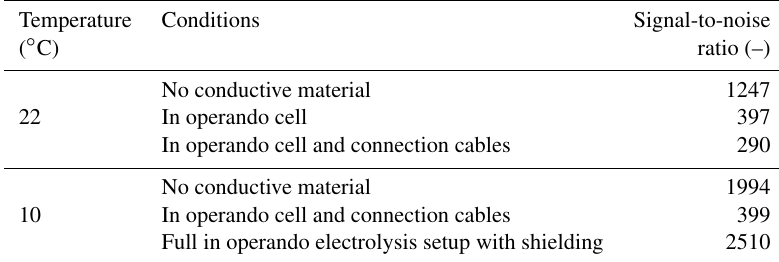
− signal under different conditions. 3